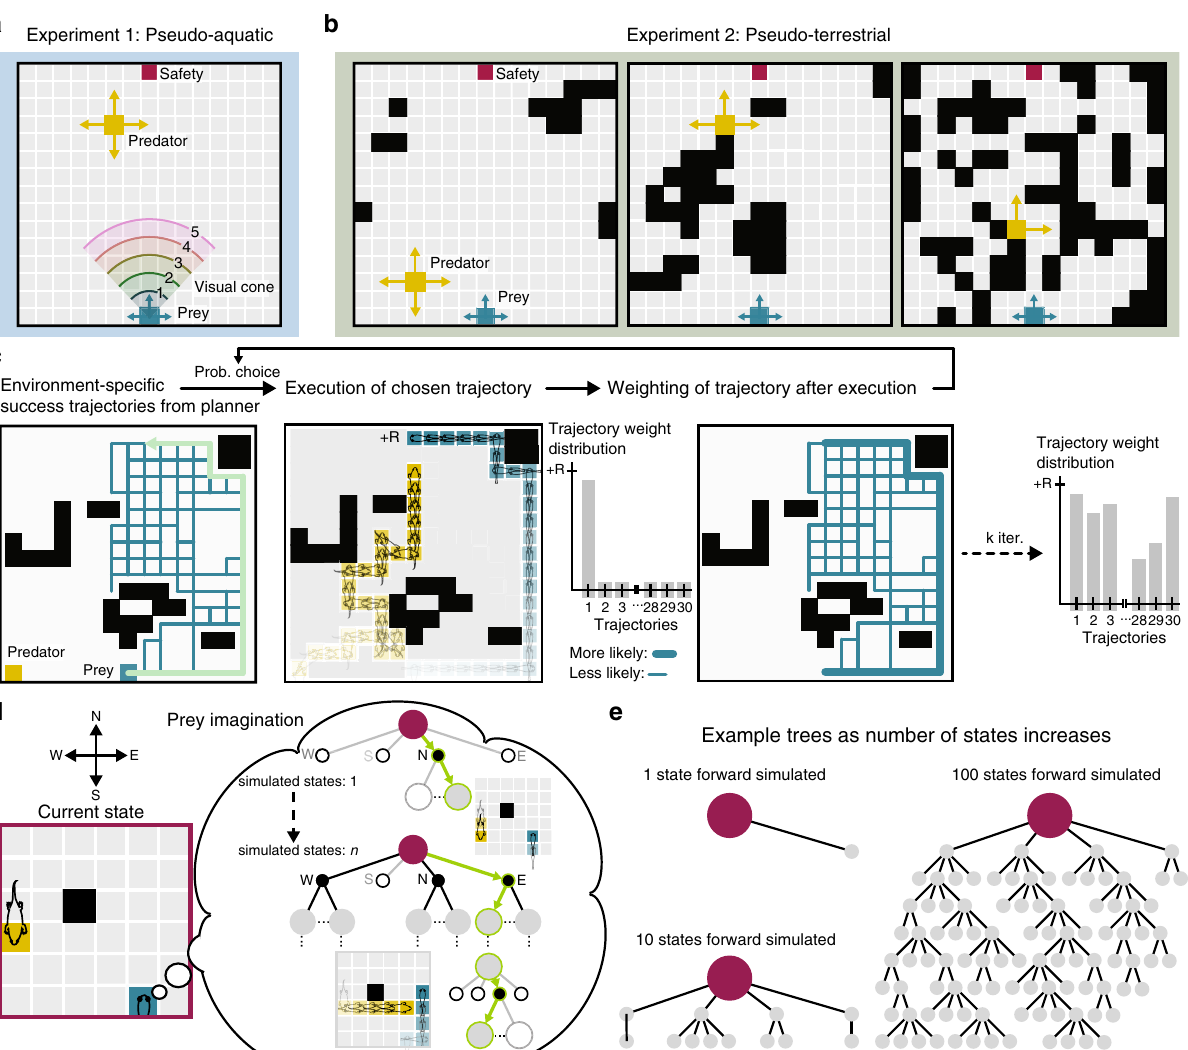
Fig. 1 Environment models and schematic of habit- and plan-based action selection. a , b Example 2-D environments used in the simulations; black squares represent obstacles. Examples of low, medium, and high clutter are shown for the pseudo-terrestrial condition. These environments can be experienced in the context of a predator-prey online game at https://maciverlab.github.io/plangame/. c Schematic of habit. A set of success paths (initially all weighted equally) are used in a loop in which a path is selected (green line with arrow) with probability proportional to its weight. After execution, the path is weighted by its total discounted reward, provided that it resulted in survival. Example weight distribution after k trials. d Schematic of planning. The prey imagines a tree of possibilities from the current state (dark red) by selecting virtual actions (green: next action and next state, white fi ll and black edge: unexplored possible actions, white fi ll and gray edge: unexplored possible next states, black fi ll: explored actions, gray fi ll: explored next states). Example virtual actions by the prey and the predator are shown on the smaller grid. e Example trees grown given a speci fi ed number of states being forward